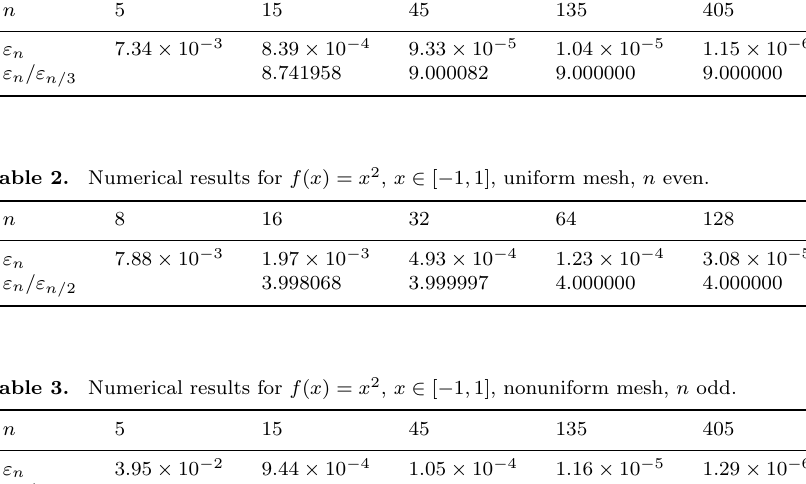
Table 1. Numerical results for f ( x ) = x 2 , x ∈ [ − 1 , 1], uniform mesh, n odd. n 5 15